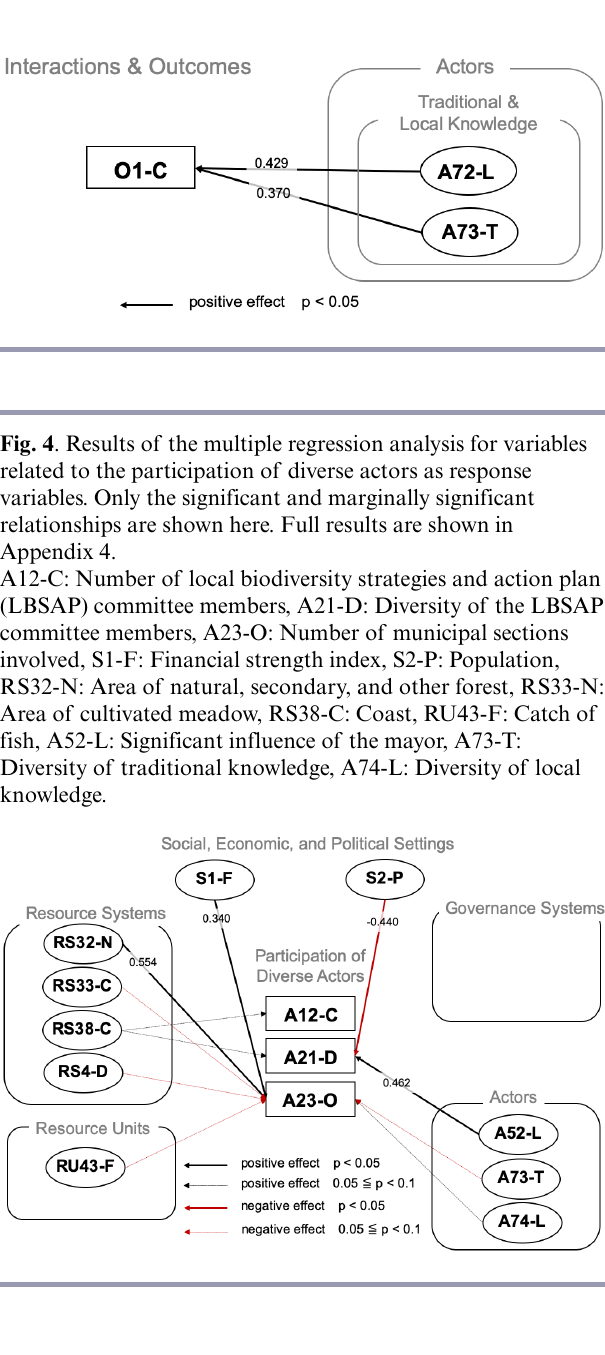
Fig. 3 . Results of the multiple regression analysis for variables related to outcomes of the social-ecological system framework as response variables. Only the significant and marginally significant relationships with variables related to the participation of diverse actors and traditional and local knowledge are shown here. Full results are shown in Appendix 2.